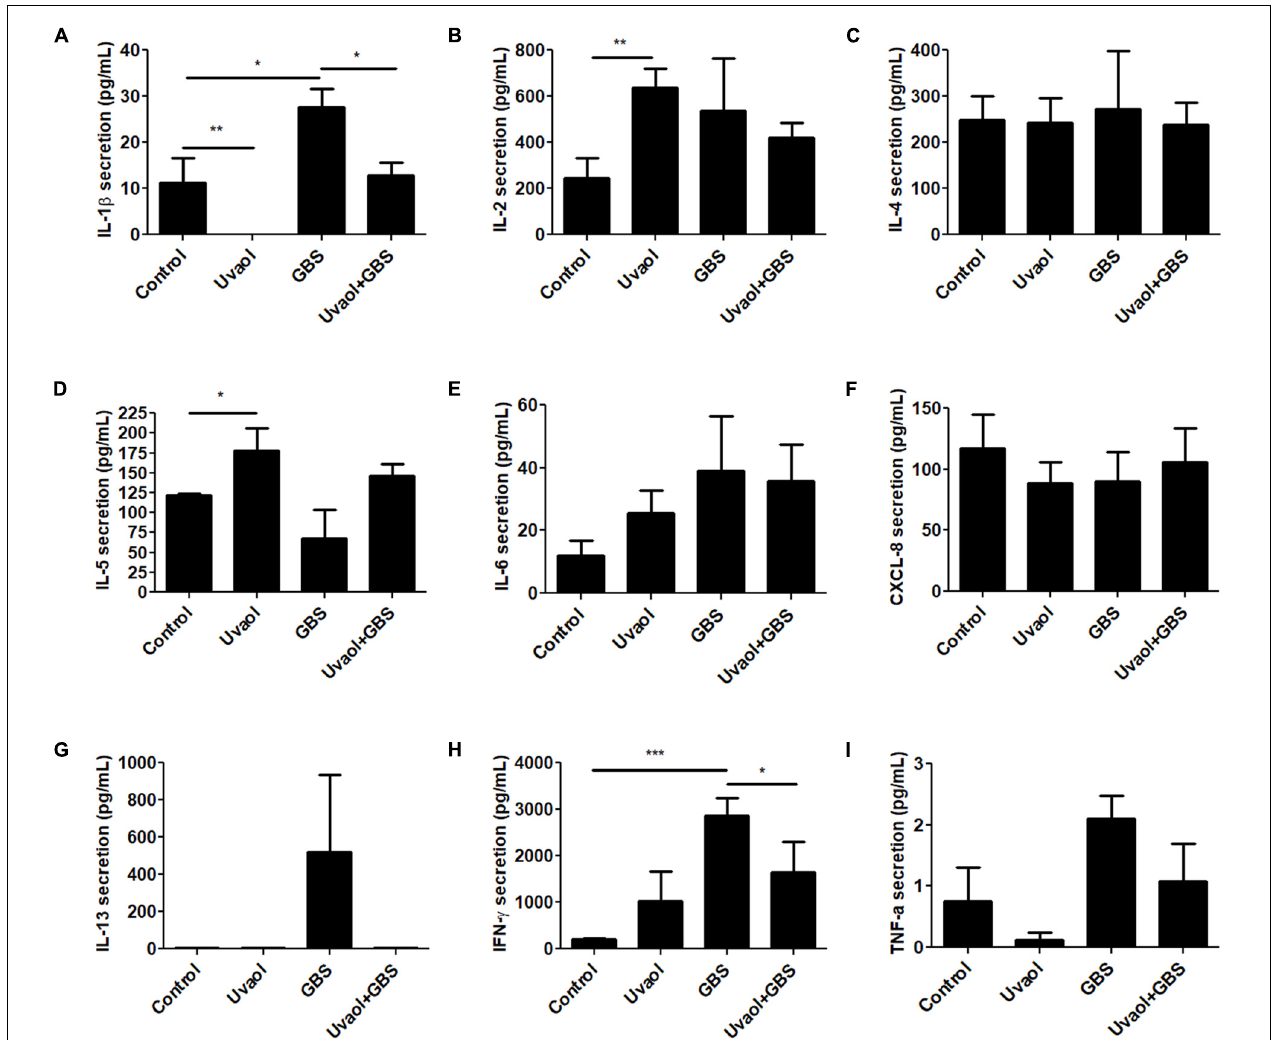
FIGURE 3 | Cytokine production of trophoblast cells is altered by GBS and uvaol. HTR-8/SVneo cells were treated with 10- µ M uvaol (uvaol), GBS at 1 × 10 6 CFU, or both for 24 h, and the supernatants were analyzed for IL-1 β (A) , IL-2 (B) , IL-4 (C) , IL-5 (D) , IL-6 (E) , CXCL-8 (F) , IL-13 (G) , IFN- γ (H) , and TNF- α (I) by flow cytometry. Bar graphs represent mean values ± S.E.M.; n = 6 in duplicate. *, p < 0.05; **; p < 0.01; ***, p < 0.001. One-way ANOVA with Tukey post hoc